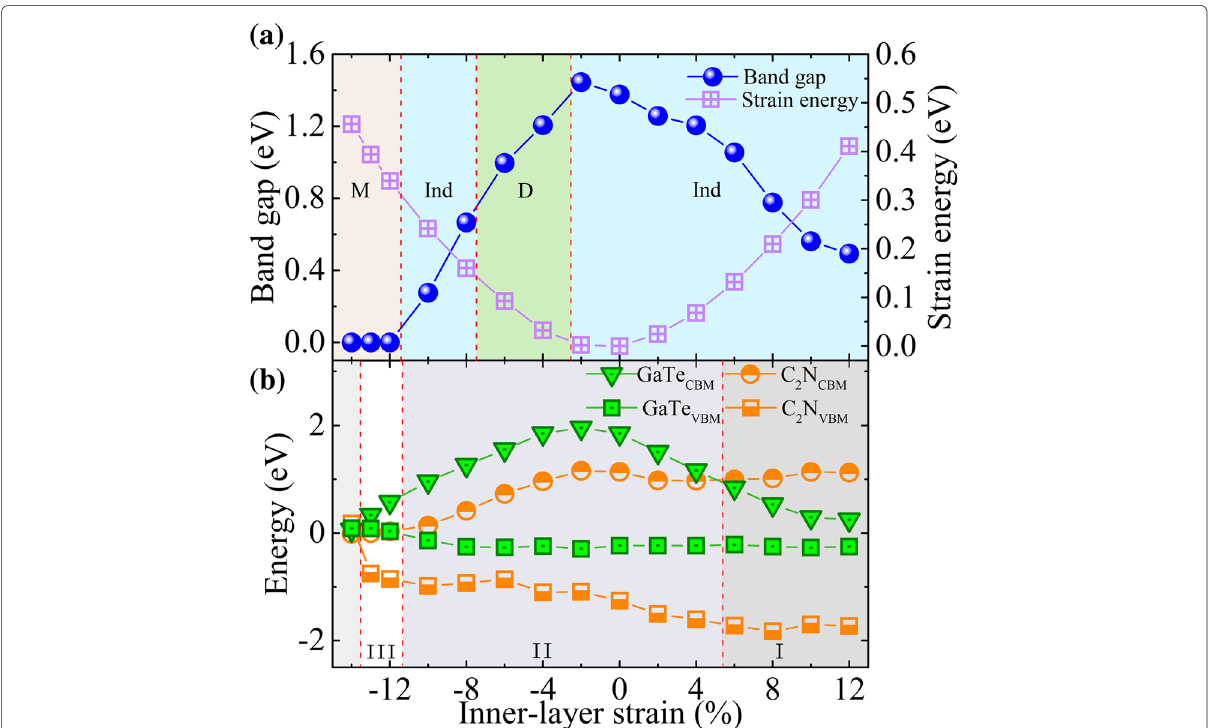
Fig. 6 a In-plane biaxial strain effects on the bandgap and strain energy of the GaTe/C 2 N heterostructure.The mistyrose, blue, and green regions represent the metal (M), Ind and D bandgap ranges, respectively. b The evolutions of the band-edge positions of the sublayers in heterostructure as a function of the in-plane biaxial strain. The I, II, and III regions correspond to type-I, -II, and -III band alignments,